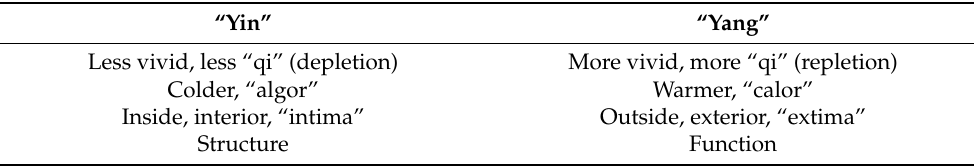
Table 2. Meanings of “yin yang” within the medical context (adapted with permission from Greten, H. (2008). Copyright 2008 Heidelberg School of Chinese Medicine [10]).